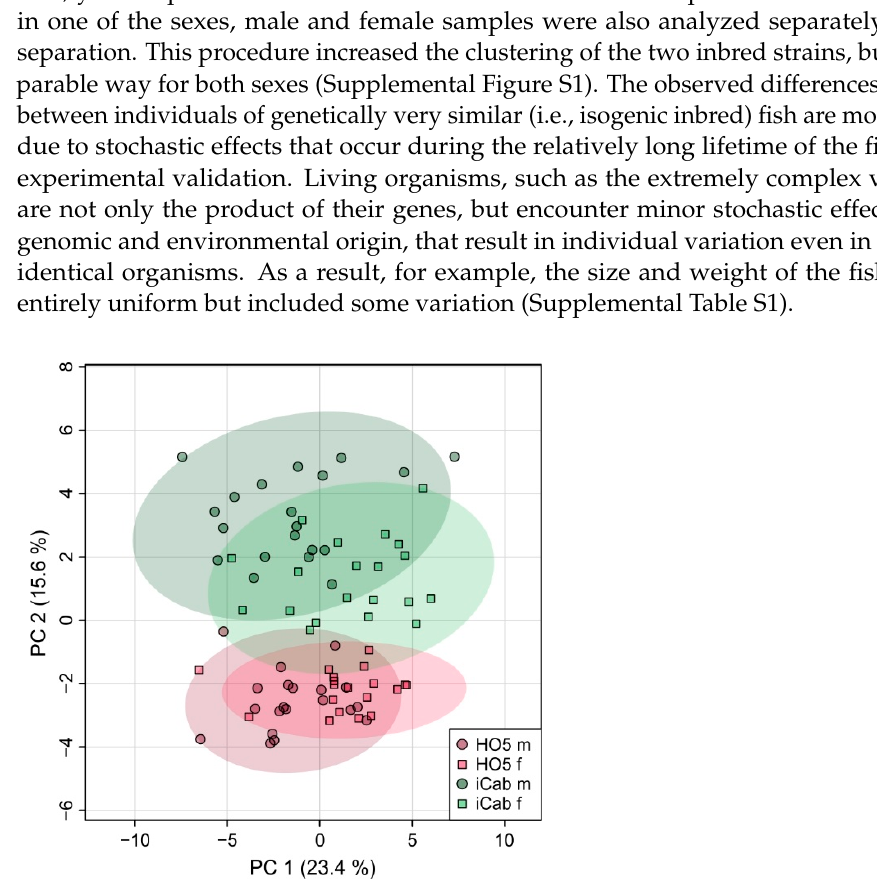
Figure 2. Principal component analysis comparing metabolic profiles of all samples, classified into HO5 male, HO5 female, iCab male and iCab female.